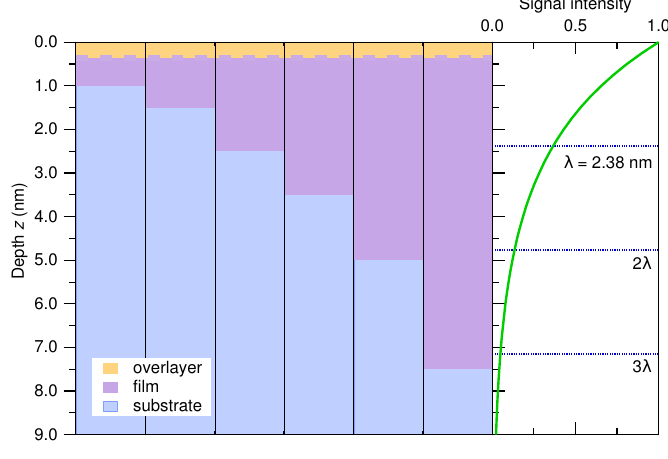
Figure 4. A summary of the depth-resolved HAXPES analysis of the six VO To the right is the exponential profile of the HAXPES probing depth for